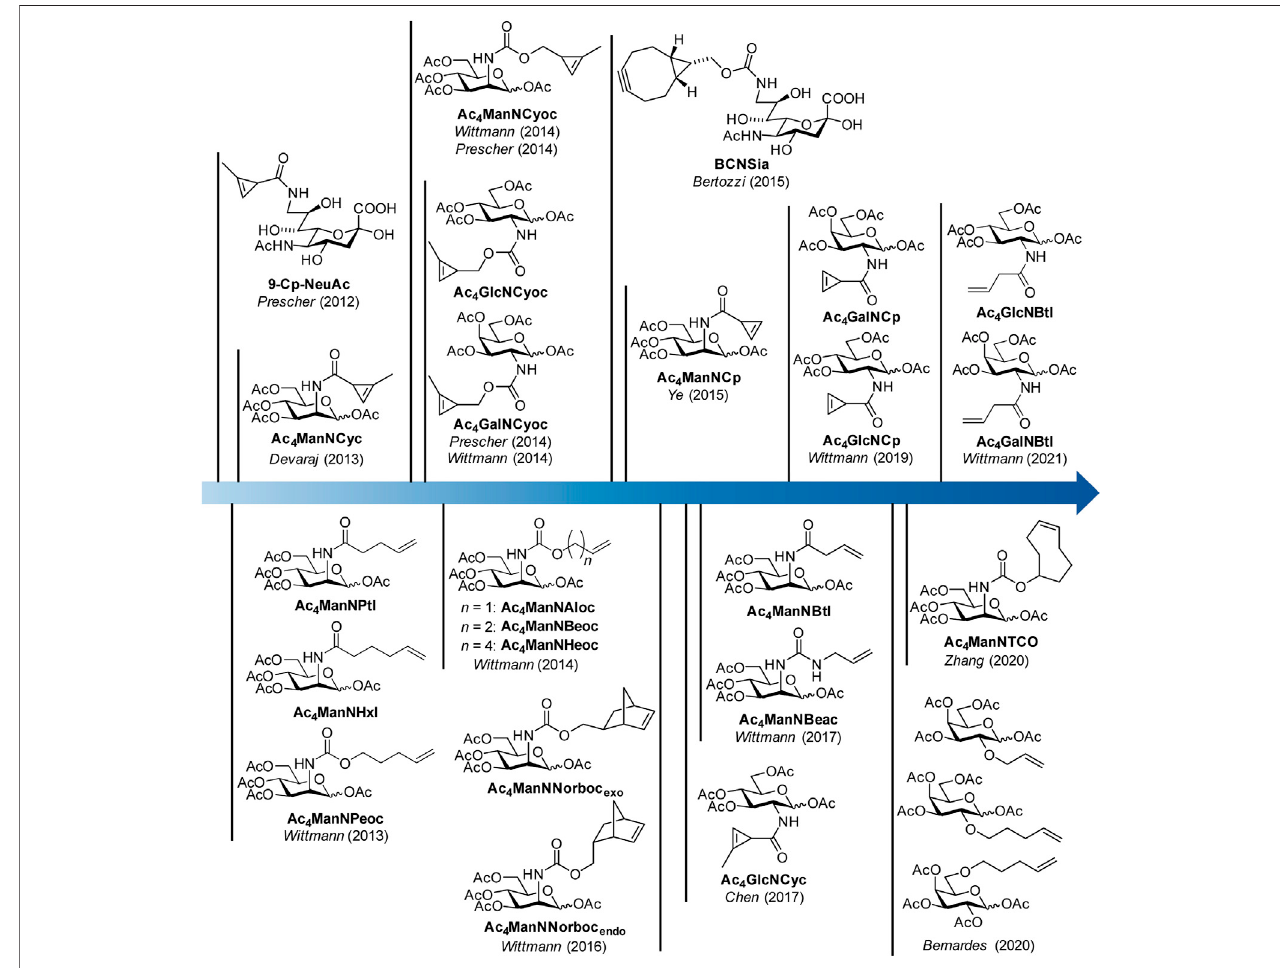
FIGURE 1 | Timeline of synthetic carbohydrate derivatives for MGE with dienophile reporter groups for bioorthogonal labeling with the IEDDA reaction.